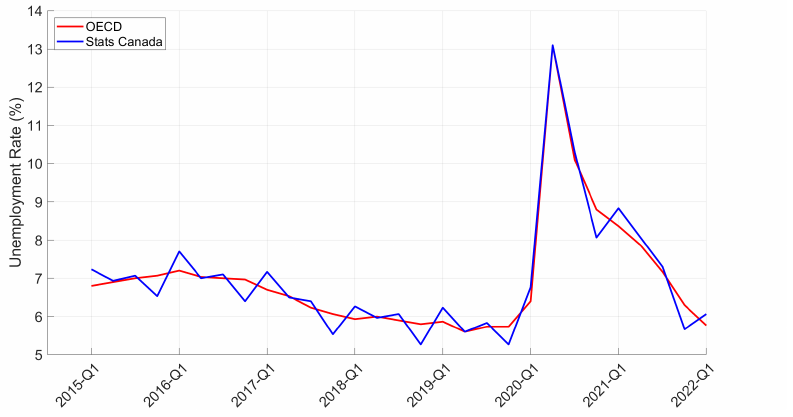
Figure 10. Comparison between OECD and Stats Canada quarterly unemployment rates.